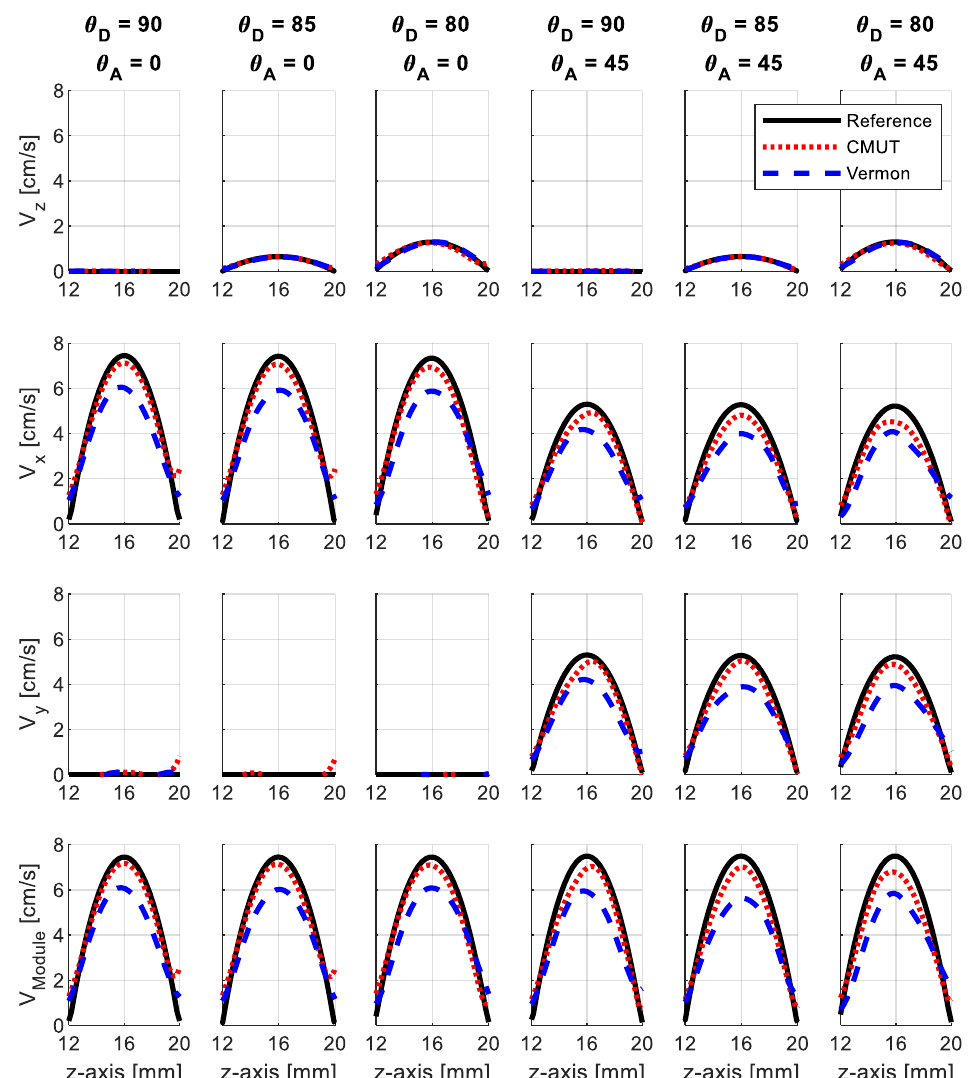
Figure 5. Velocity profiles reconstructed along lines crossing the probe axis with different probe-to-flow orientations. The red dotted lines refer to the CMUT probe, the blue dashed ones to the Vermon probe. The black solid line is the reference velocity profile.